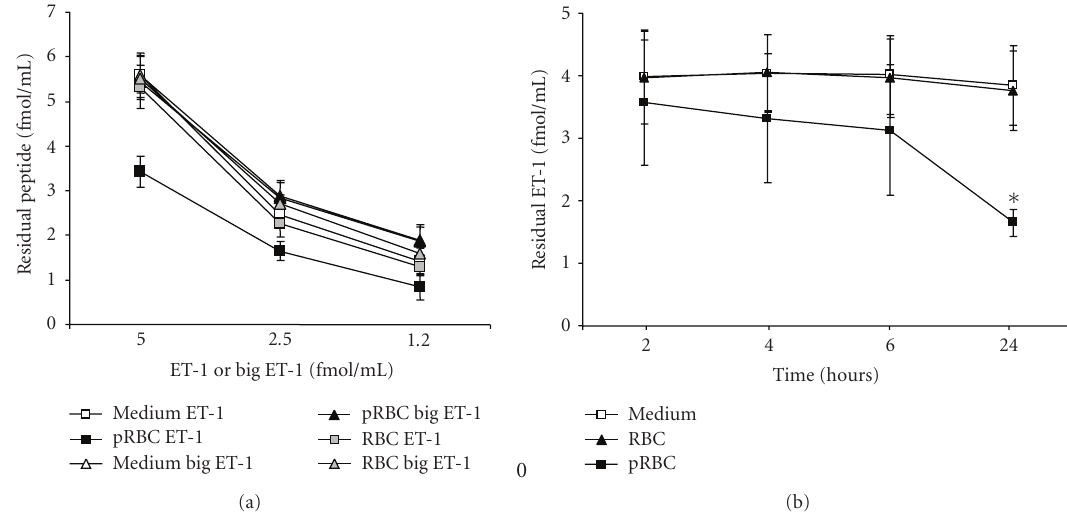
Figure 2: E ff ect of incubation of pRBC (D10 strain) or normal RBC on synthetic ET-1 and big Et-1. (a) Di ff erent concentrations of ET-1 (square) or big ET-1 (triangle) were incubated in medium (empty symbols) or in the presence of uninfected RBC (grey symbols) or pRBC (black symbols). After 24 hours of incubation, samples were collected and assayed for the presence of the residual ET-1 or big et-1 by ELISA. The results represent the mean ± SD from three di ff erent experiments. (b) ET-1 (5 fmol/mL) was incubated in medium (empty square) or in the presence of pRBC (black square) or control RBC (black triangle) for 2, 4, 6, 24 hours. At the end of incubation, samples were collected and assayed for the presence of the residual ET-1. Results represent mean ± SD from three di ff erent experiments ( ∗ P = . 029 versus medium).